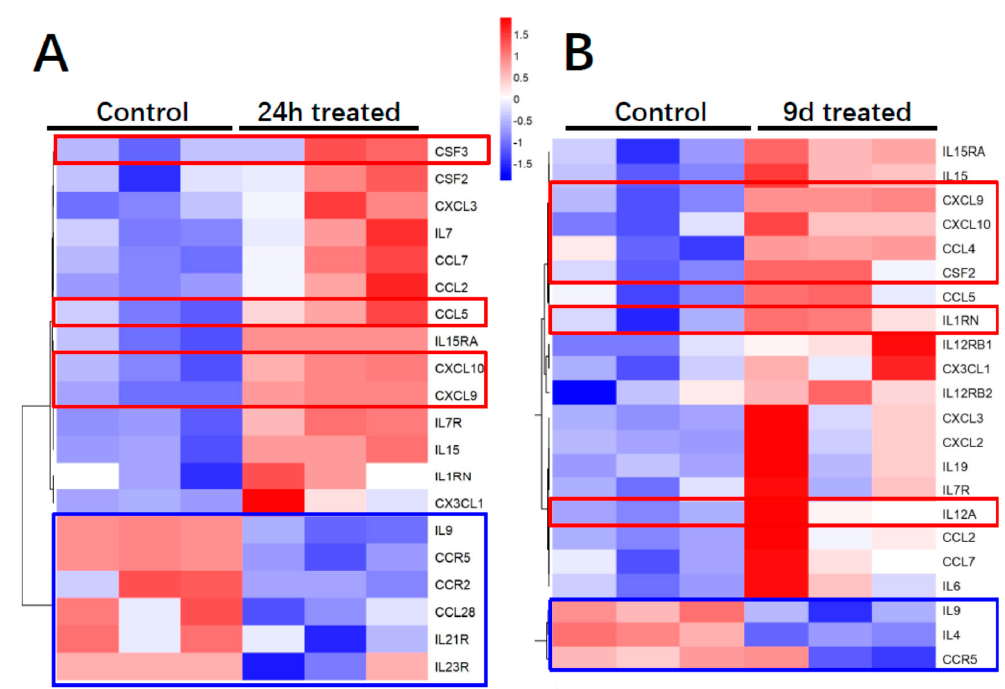
Figure 5. Effect of inflammation on ADHLSC cytokine and cytokine receptors transcriptome profile. ( A , B ) Heat map presenting the differential cytokine upregulated and downregulated mRNA expression profile after 24 h and 9 days of inflammation priming ( n = 3 samples from different donors).